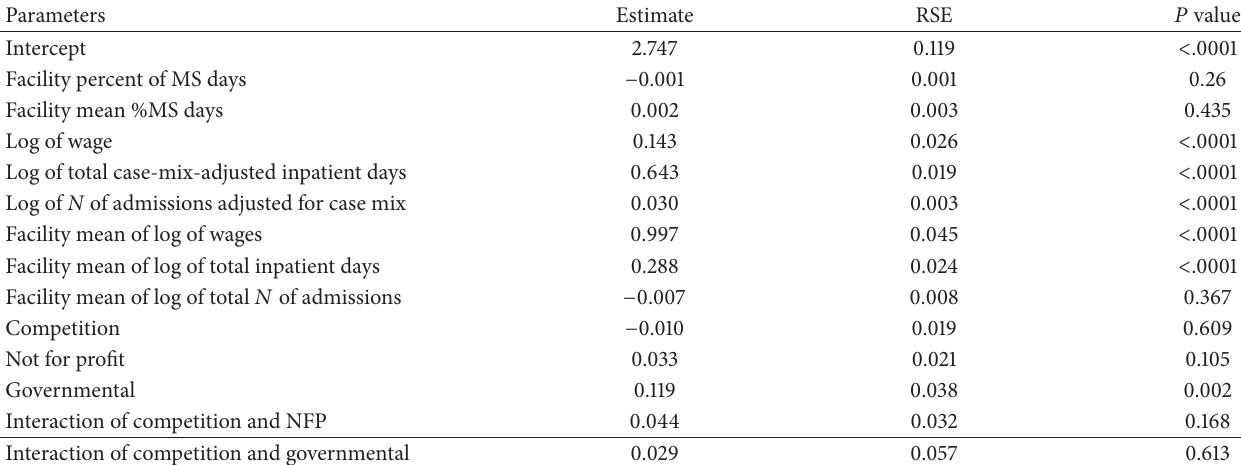
Table 4: Effect of MS volume on SNF inpatient costs (Model